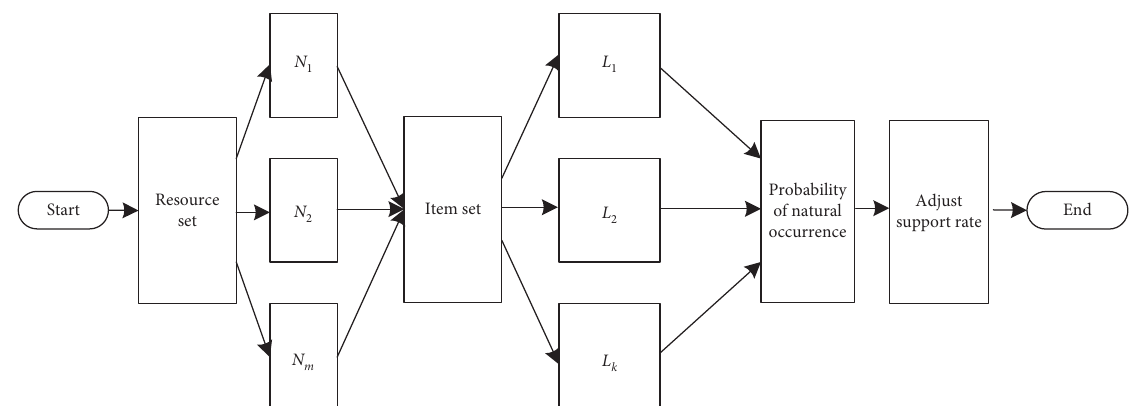
Figure 2: The process of remote education resource mining.